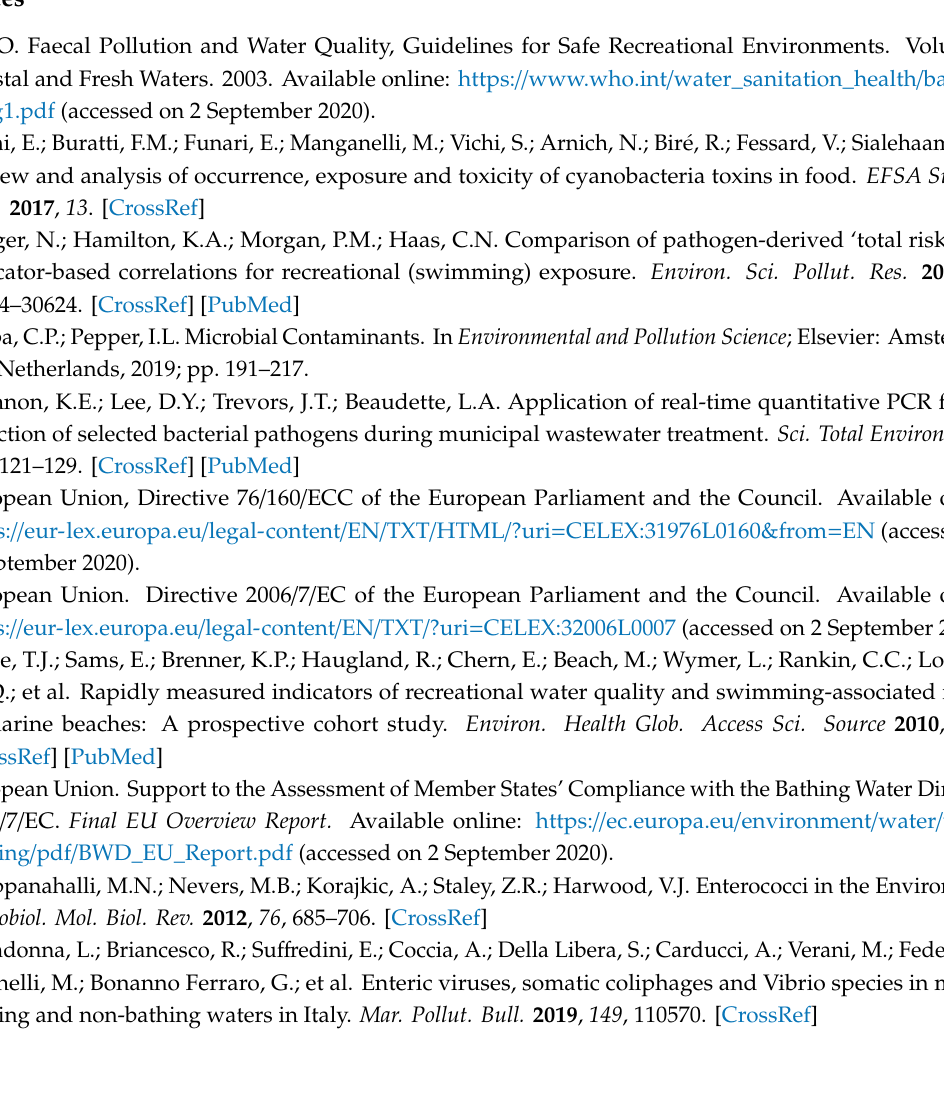
Supplementary Materials: The following are available online at http: // www.mdpi.com / 2073-4441 / 12 / 11 / 3146 / s1, Figure S1: log Vibrio spp. concentration in CFU 100 mL -1 obtained in May–September 2018 along the coast of Lithuania and the Curonian Lagoon. Error bars represent the SD (N = 3), Table S1: Environmental conditions at the sampling sites (mean ± standard deviation (SD), minimum (Min) and maximum (Max), extracted from Overling˙e et al. (2020) [20], Table S2: Summary of microbial indicators of water quality per sampling period of 2018 and study sites along Lithuanian coast of the Baltic sea and the Curonian Lagoon, Table S3: Results of log-linear